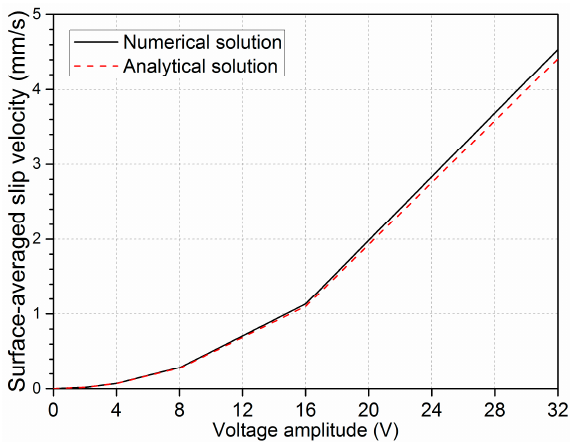
Figure 4. A comparison of surface-averaged slip velocity predicted by numerical and analytical solutions at different excited voltages when Da is 660 at 10 Hz.